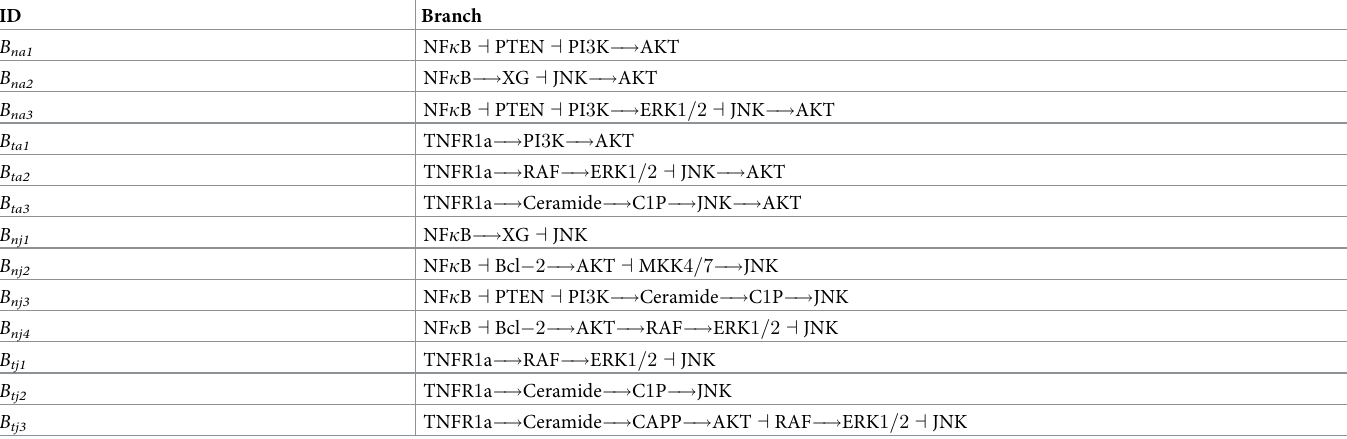
Table 1. Major branches originating from NF κ B or TNFR1 and ending in the signaling entities pAKT or pJNK. Comprehensive list of all branches are presented in S5 Table.